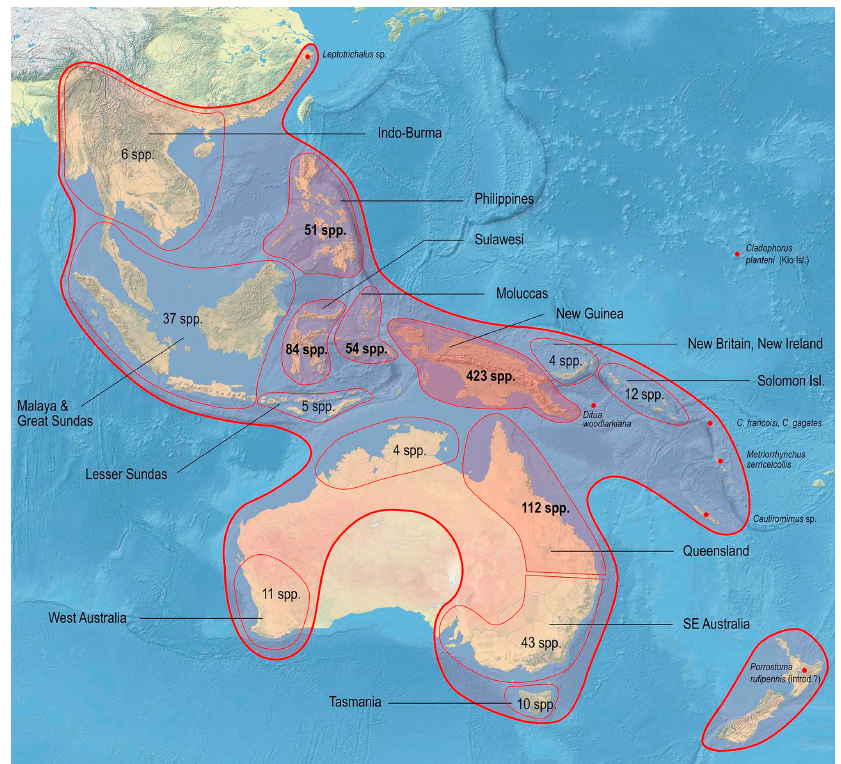
Figure 2. Distribution and diversity of the subtribe Metriorrhynchina.